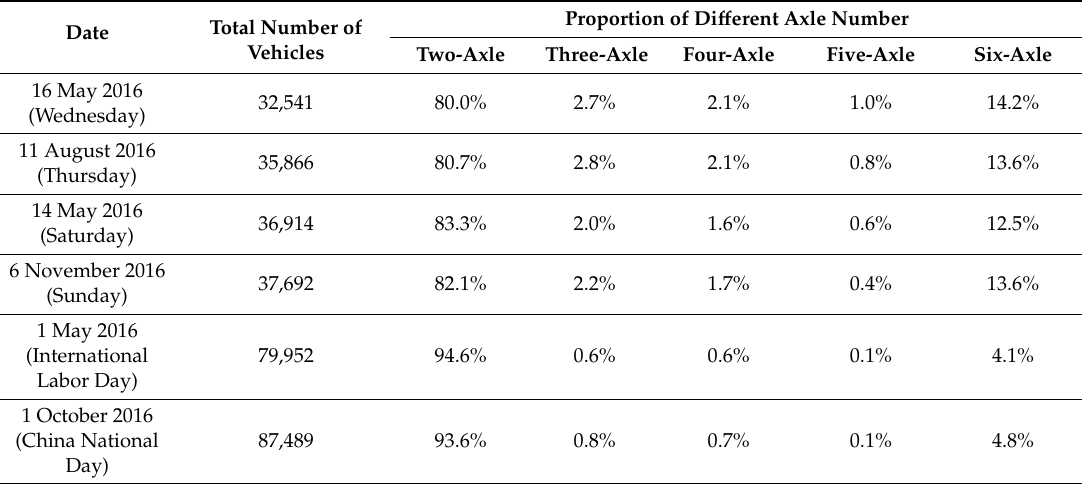
Table 4. Statistical results of axle number distribution.